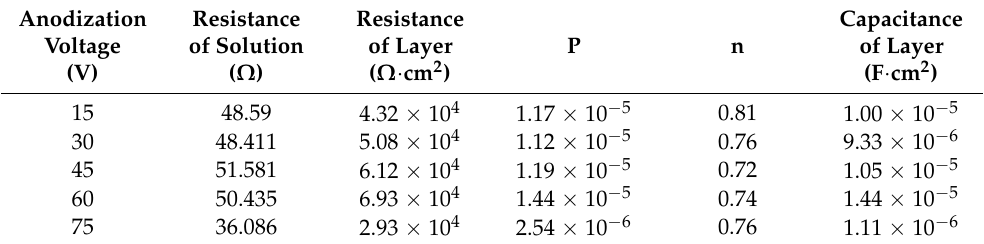
Table 3. Values of elements of fitted equivalent circuit .